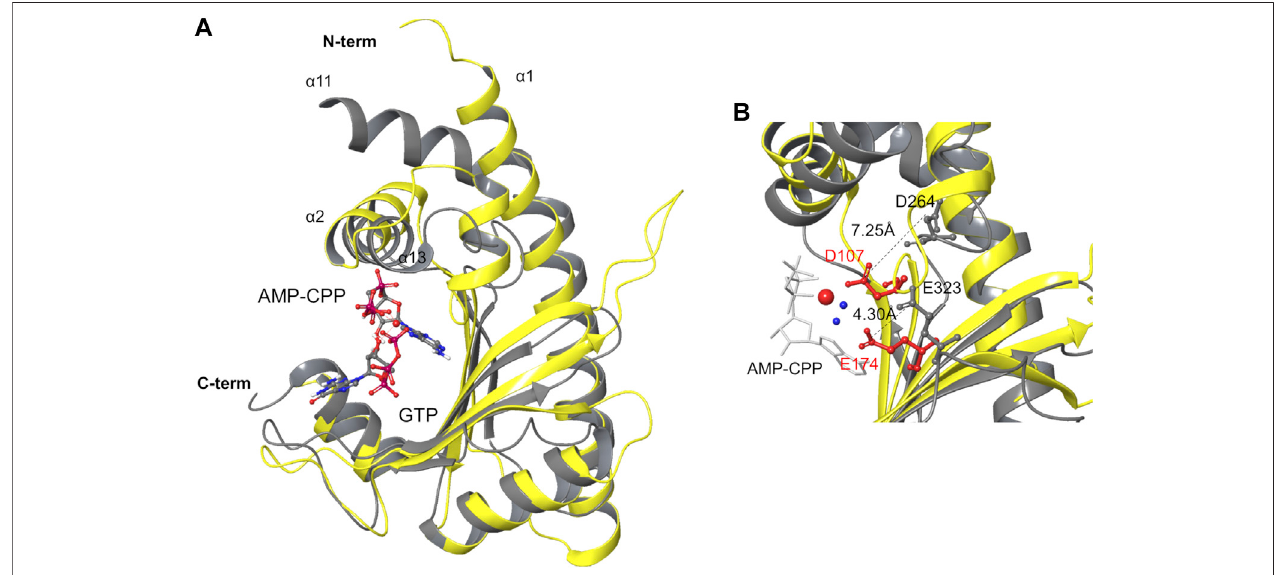
FIGURE3 | Structure superimposition ofthe SYNTH domains ofRel Seq and RelP. (A) Superimposition ofRel Seq SYNTHdomain (gray ribbons, 1VJ7. pdb chain A, residues 197 – 341,with GDP ligand) and RelP (yellow ribbons, 6EWZ.pdb, chainA, residues 29 – 188). (B) Catalytic residues ofboth enzymes are shown (D264, E323 of Rel Seq in gray, D107, E174 of RelP in red). Distances between the side chains are reported as calculated on the C atoms of the carboxylate groups. Mg 2+ is shown as a red sphere with the two coordinated waters in blue, AMP-CPP is in white tube representation while GTP is omitted for